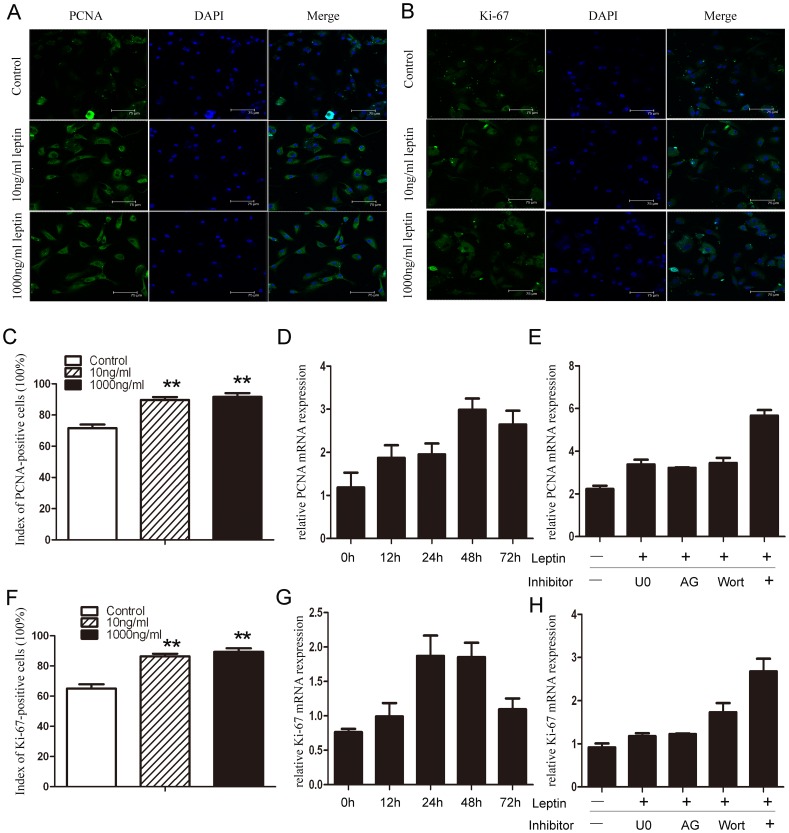
Immunohistochemical staining of NP cells against PCNA and Ki-67.After 1-day serum deprivation, NP cell were treated vehicle (control), 10 ng/ml leptin in serum-free medium for 48 h. Immunohistochemical staining of NP cells against PCNA (A) and Ki-67(B). Nuclei were stained with DAPI, shown in blue. Images were acquired using laser scanning confocal microscopy under a 40× objective. PCNA-positive (C) and Ki-67(D) percentages in cultured NP cells 48 h after different concentrations of leptin and vehicle (control). Values are presented as mean ±SD. As compared with control, **p<0.01. (C–D) Real-time RT-PCR analysis of PCNA and Ki-67 mRNA expression in NP cells following leptin treatment for 0, 12, 24, 48 h, or 72 h. Real-time RT-PCR analysis was performed in triplicate and the expression levels of PCNA and Ki-67 mRNAs were normalized to GAPDH mRNAs. Error bars represent standard deviration. (E–F) NP cells were serum starved for 24 h, and then treated with vehicle (−), 10 ng/ml leptin (+), 10 µM U0126 (U0), 40 µM AG490 (AG) or 250 nM wortmannin (Wort) for 48 h. PCNA and Ki-67 mRNA expression were detected with Real-time RT-PCR analysis using GAPDH as an internal control. Error bars represent standard deviration.